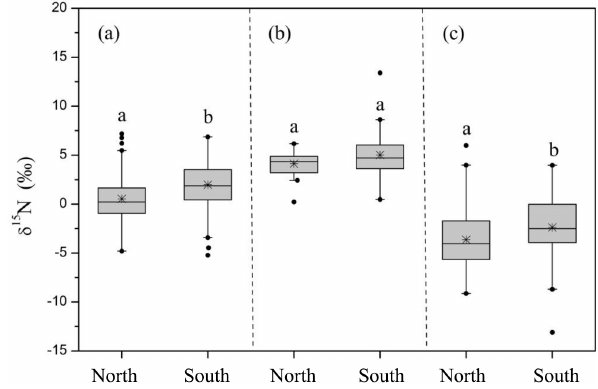
Figure 2. Differences in (a) leaf δ 15 N, (b) soil δ 15 N and (c) δ 15 N leaf-soil between the north and south slopes of Tian Shan.Each box represents the range of the middle 50% of group values; the center lines and points within the boxes are the median and mean values. Whiskers represent the 25 and 75% percentiles, and outliers are plotted as dots outside this range.